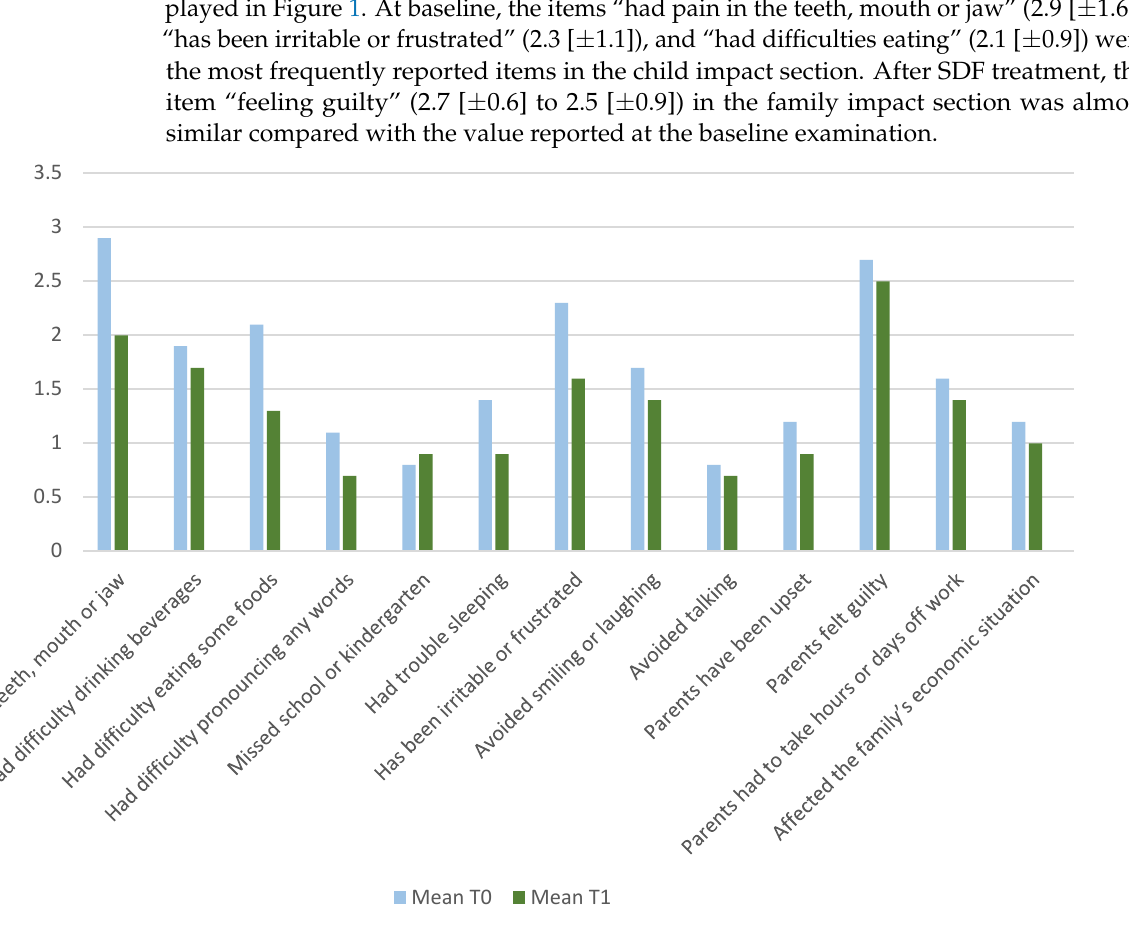
Figure 1. Responses to the German Early Childhood Oral Health Impact Scale (ECOHIS-G) items.